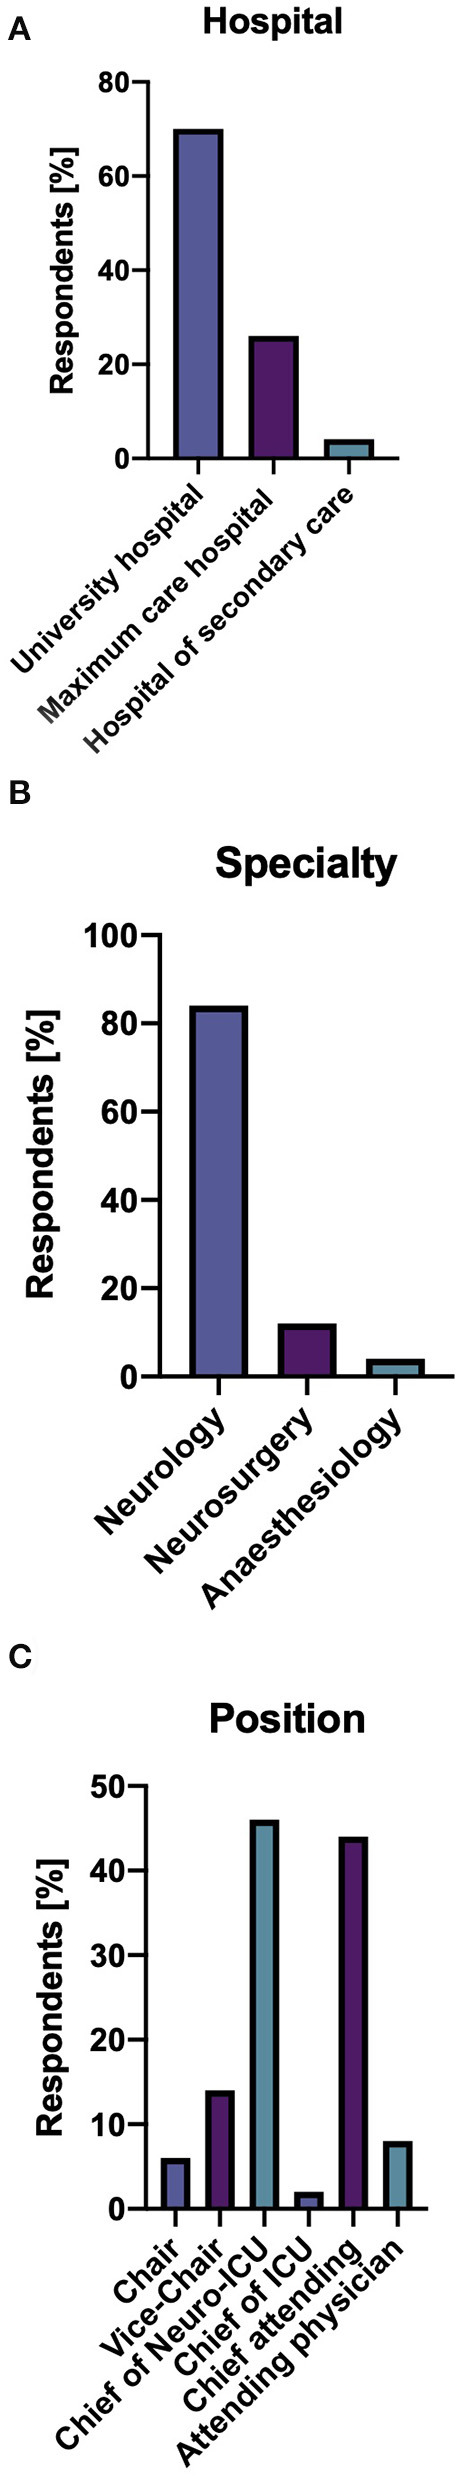
Characteristics of respondents. Bar charts of (A) type of institution, (B) respondent specialty, and (C) respondent position.